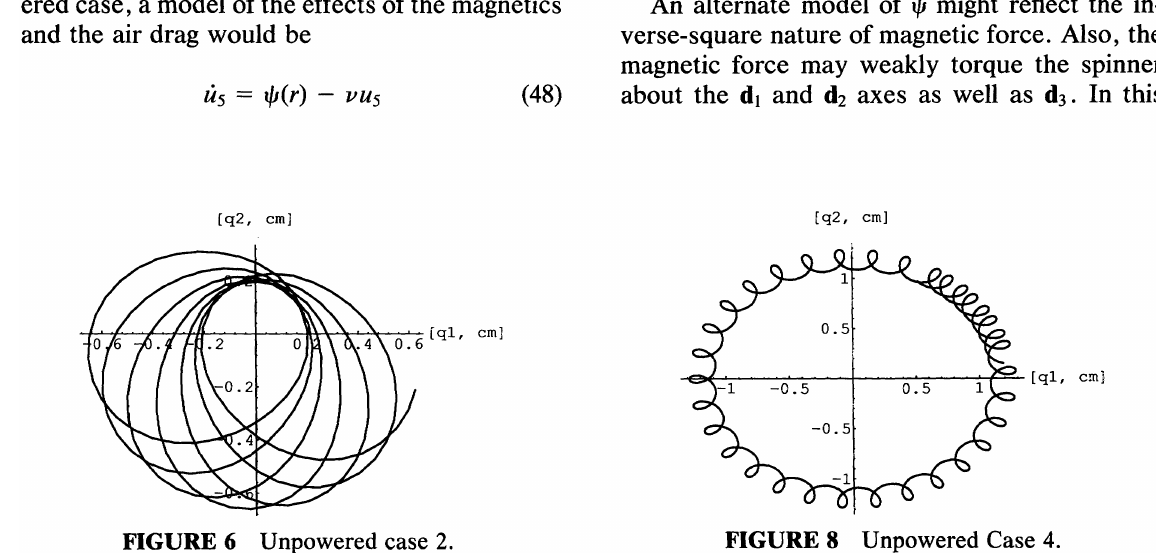
FIGURE 6 Unpowered case 2.